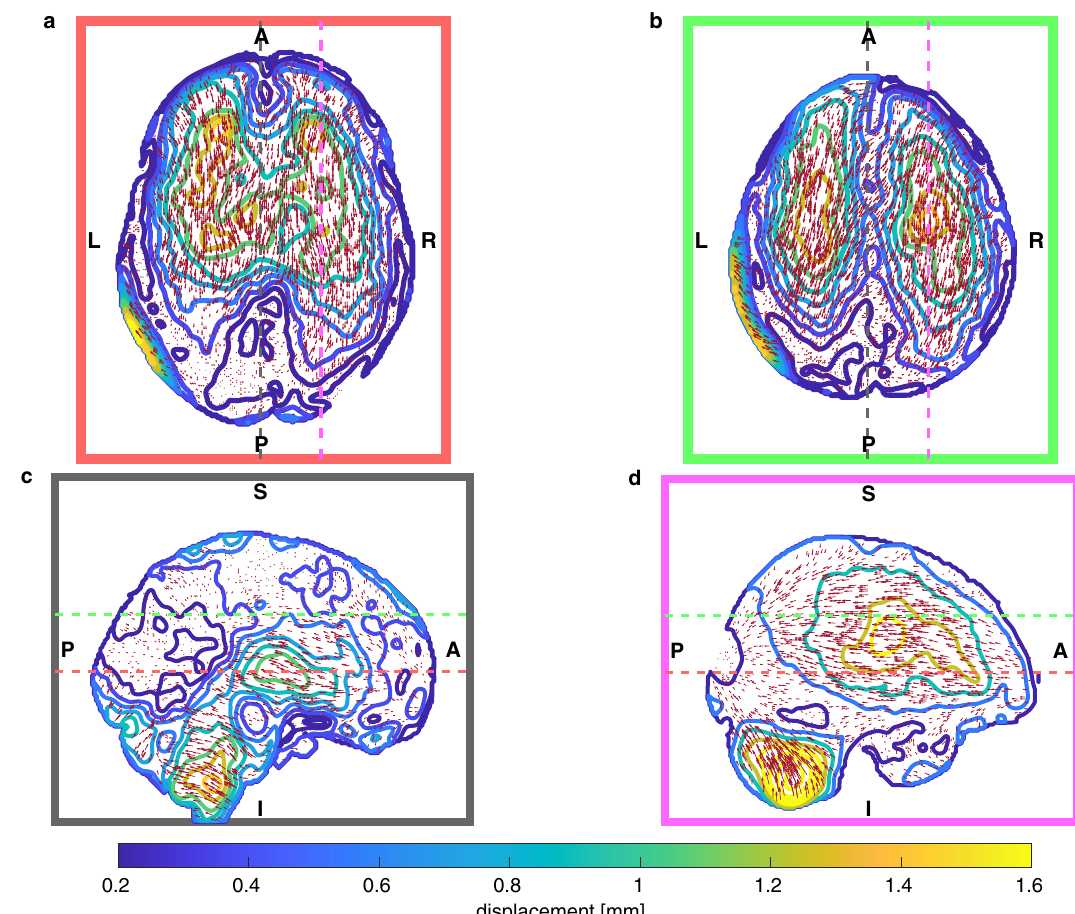
Figure 2. Vector plots of PBS for two axial ( a and b ) and two sagittal ( c , d ) slices. Length of vectors have been scaled for visualisation purposes: their magnitude is represented by the underlying contour plots. As reference, dashed coloured lines represent the position of the other slices. In particular, slice a was positioned at the level of the anterior and posterior horns of the lateral ventricles, whereas slice c was positioned at the level of the falx